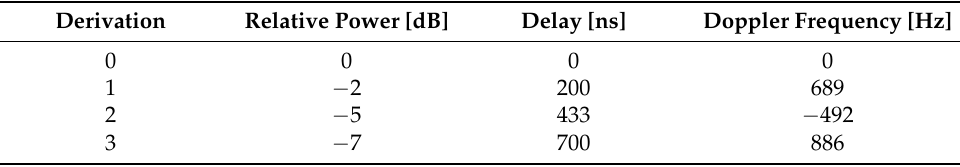
Table 3. Derivation-delay-Doppler processing